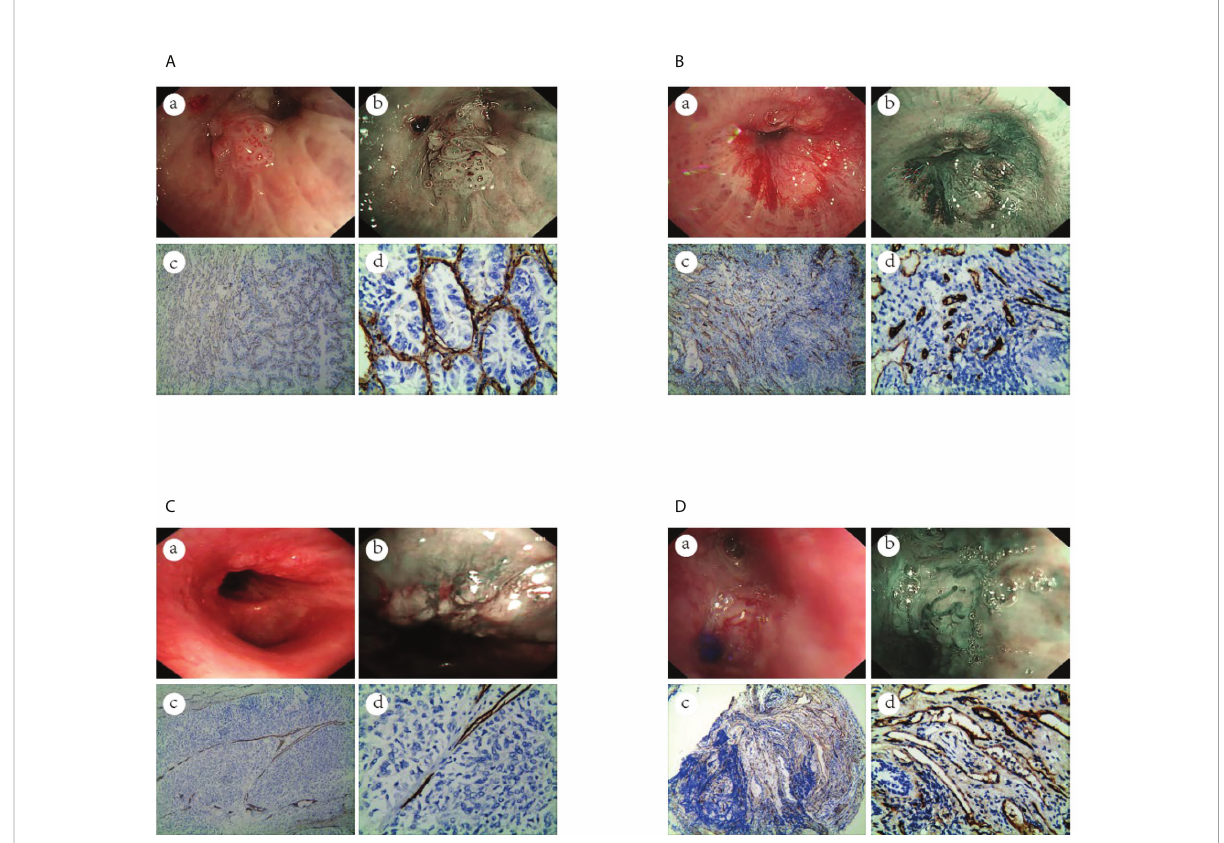
FIGURE 5 The vascular images of WLB, NBI and histological specimens after IHC for malignant lesions. (A) Dotted blood vessels in adenocarcinoma of the lung (a) WLB image. (b) NBI shows that there are obvious dotted blood vessels. (c, d) IHC staining of the tissue specimen shows that there are obvious dotted blood vessels(the scale of Figure c is 100 m m, the scale of Figure d is 50 m m). (B) Tortuous blood vessels in SCC of the lung (a) WLB image. (b) NBI shows that there are obvious tortuous blood vessels. (c, d) IHC staining of the tissue specimen shows that there are obvious tortuous blood vessels(the scale of Figure c is 100 m m, the scale of Figure d is 50 m m). (C) Abrupt-ending blood vessels in SCC of the lung (a) WLB image. (b) NBI shows that there are obvious abrupt-ending blood vessels. (c, d) IHC staining of the tissue specimen shows that there are obvious abrupt-ending blood vessels(the scale of Figure c is 100 m m, the scale of Figure d is 50 m m). (D) Tortuous blood vessels in SCLC of the lung (a) WLB image. (b) NBI shows that there are obvious tortuous blood vessels. (c, d) IHC staining of the tissue specimen shows that there are obvious tortuous blood vessels (the scale of Figure c is 100 m m, the scale of Figure d is 50 m